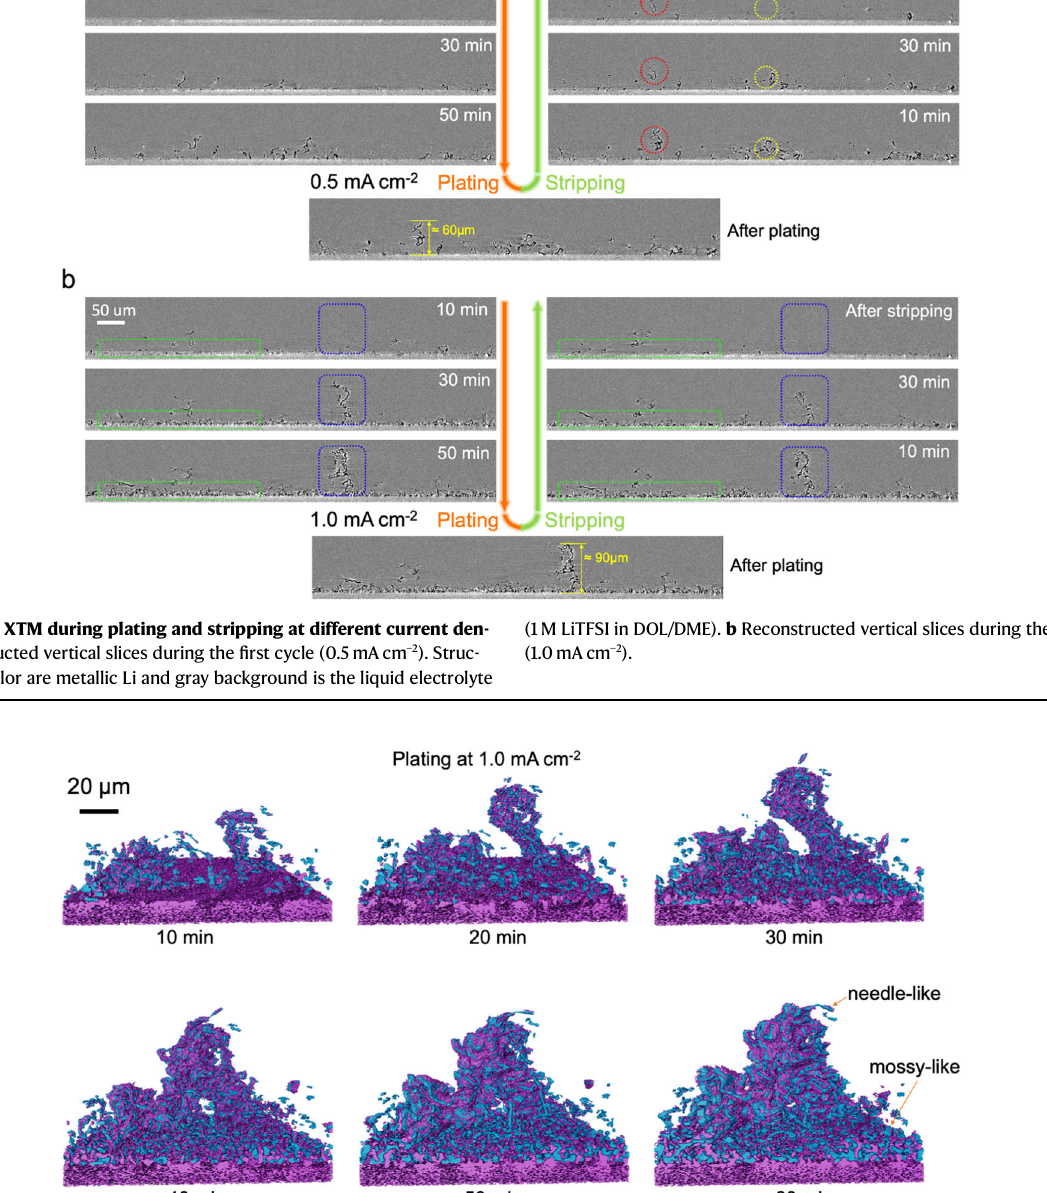
covering LiisSEI or high atomic number components, and purple in the bottom is Cu